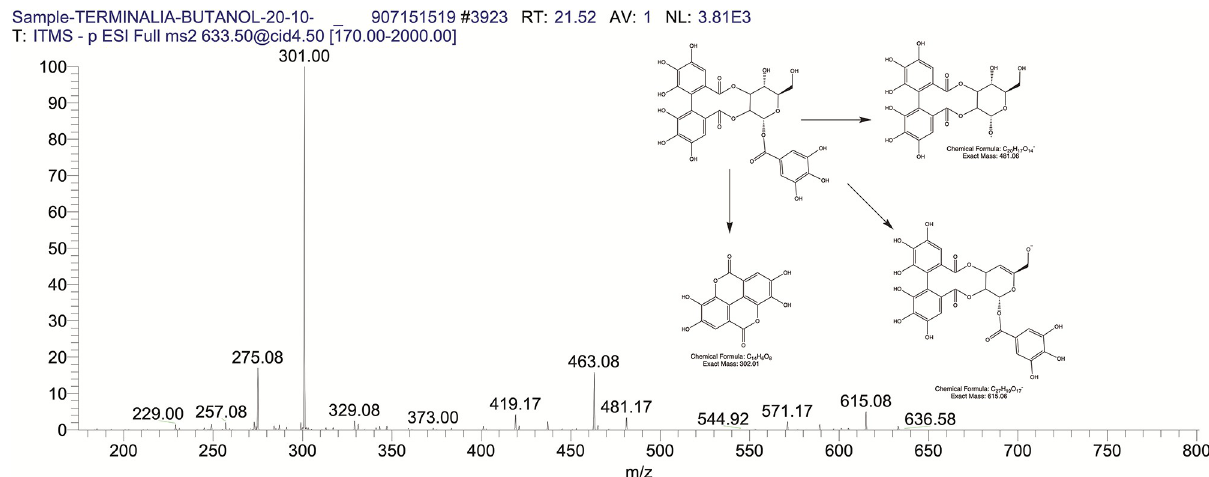
Fig 5. The mass spectrum of galloyl HHDP hexoside and its fragmentation pattern.